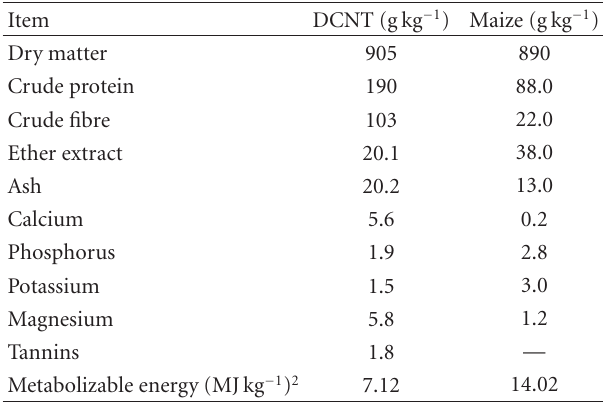
Table 2: Chemical composition of dried cashew nut testa 1